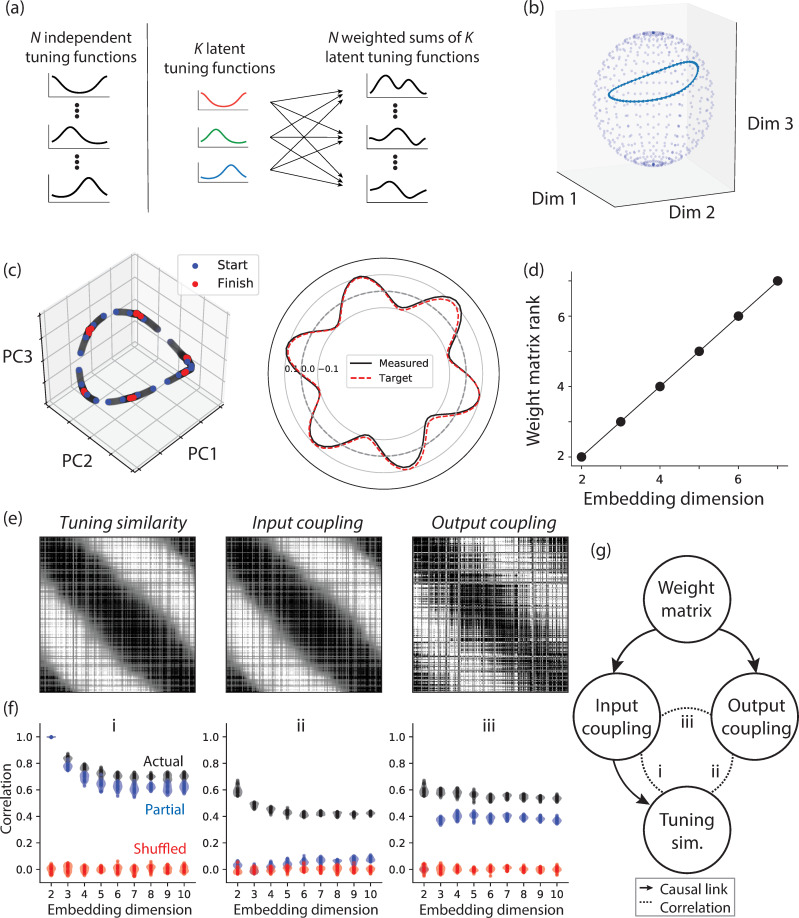
Embedding rings in higher dimensions.a) An illustration of RNN units in terms of their tuning function for a network with an embedded ring manifold. The left column illustrates a case in which the N units in the RNN have independent tuning functions. The right column illustrates a case in which the N tuning functions are weighted sums of K<<N latent tuning functions (the plot corresponds to 3 latent tuning functions shown in color). b) An example ring manifold embedded in 8 dimensions shown over a 3D slice of a hypersphere. The first two dimensions (Dim 1 and Dim 2) correspond to the sinusoidal tuning functions, and the third dimension (Dim 3) corresponds to one of the latent tuning dimensions. In this example, the ring was made from 6 von Mises functions and 2 sinusoidal functions. c) Left: The initial state (blue), intermediate states (gray), and end states (red) of an RNN engineered to have O(8,6), plotted in a subspace spanned by the first three principal components. Right: The target drift function and the drift function measured from the engineered RNN. d) The rank of the RNN weight matrix, determined by the number of non-zero eigenvalues, matches the ring’s embedding dimension. e) Left: The tuning similarity matrix measured as the covariance of tuning functions for an RNN engineered to have O(2,6). Middle: The input coupling matrix measured as the inner product of the input weight vectors for all pairs of units for the same RNN. Right: The output coupling matrix measured as the inner product of the output weight vectors for all pairs of units for the same RNN. Matrix indices are ordered by the preferred orientation of the tuning curves. f) Left: Violin plot of the correlation coefficient between the elements of the tuning similarity and input coupling matrices of engineered RNNs. The results are shown for various ring embedding dimensions with no drift over the ring. The actual correlations are shown in black, partial correlations controlling for the output coupling matrix in blue, and the values expected by chance in red. To compute chance levels, we shuffled the label of tuning functions (i.e., the rows of the tuning similarity matrix) and recomputed the correlations. Middle: Same analysis repeated for the tuning similarity and output coupling matrices, with the partial correlations controlling for the input coupling matrix. Right: Same analysis repeated for the input coupling and output coupling matrices, with the partial correlations controlling for the tuning similarity matrix. g) Causal graph showing the relationship between the input coupling matrix (left node), output coupling matrix (right node), tuning similarity matrix (bottom node), and the weight matrix (top node). The three dashed lines marked as i, ii, and iii correspond to the three correlation plots in panel f (left to right).